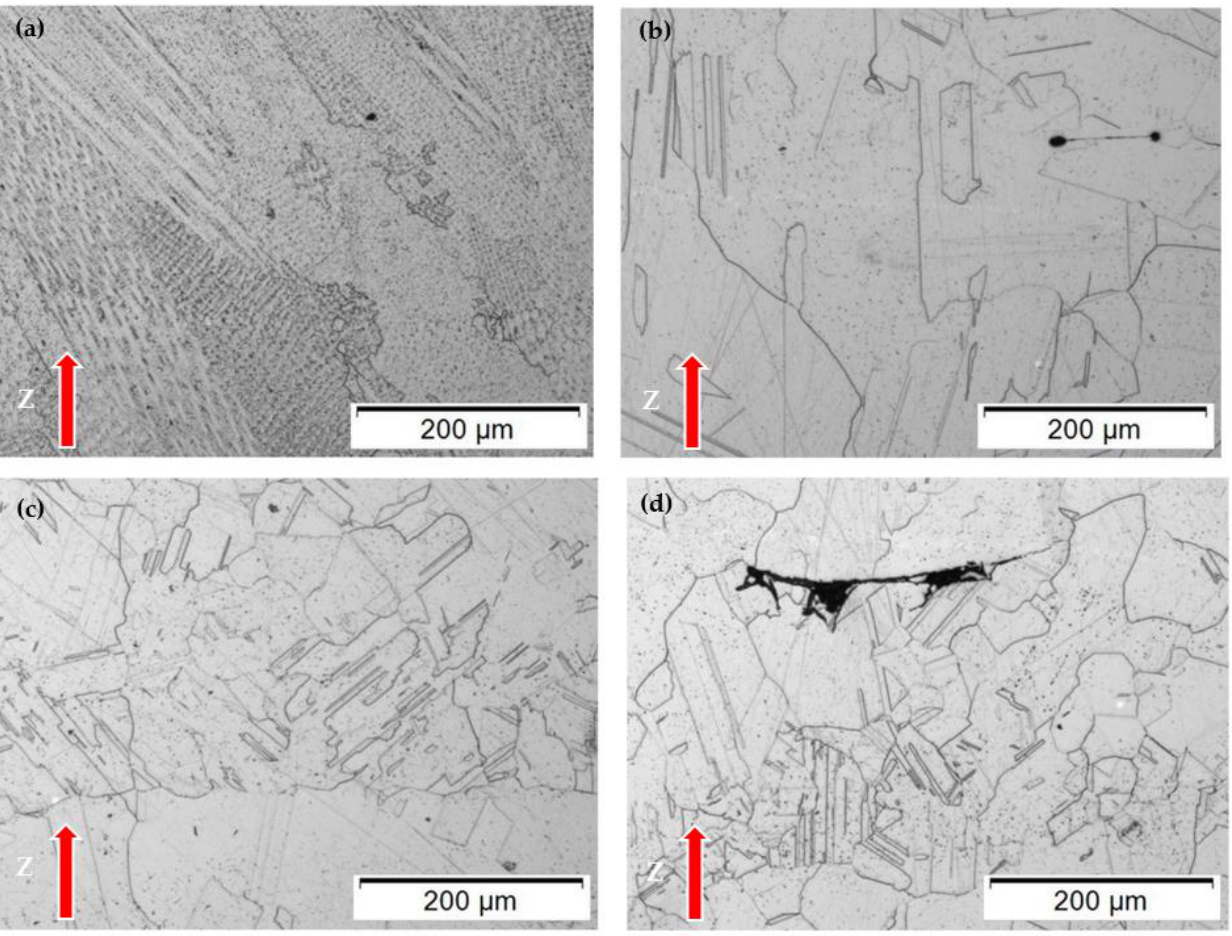
Figure 8. LW-DED optical microscope images: ( a ) as-built, ( b ) heat-treated raster, ( c ) heat-treated raster 90, ( d ) heat-treated linear 1.